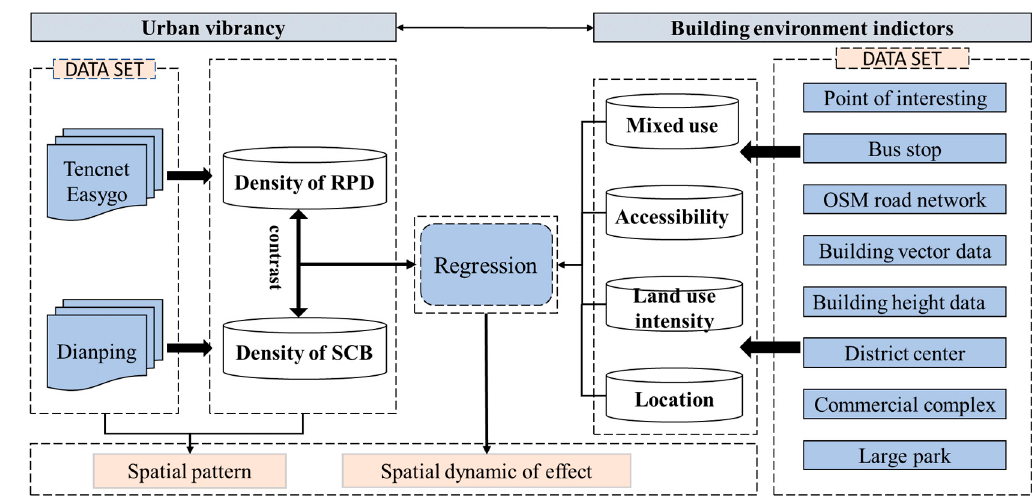
Figure 2. Research framework.